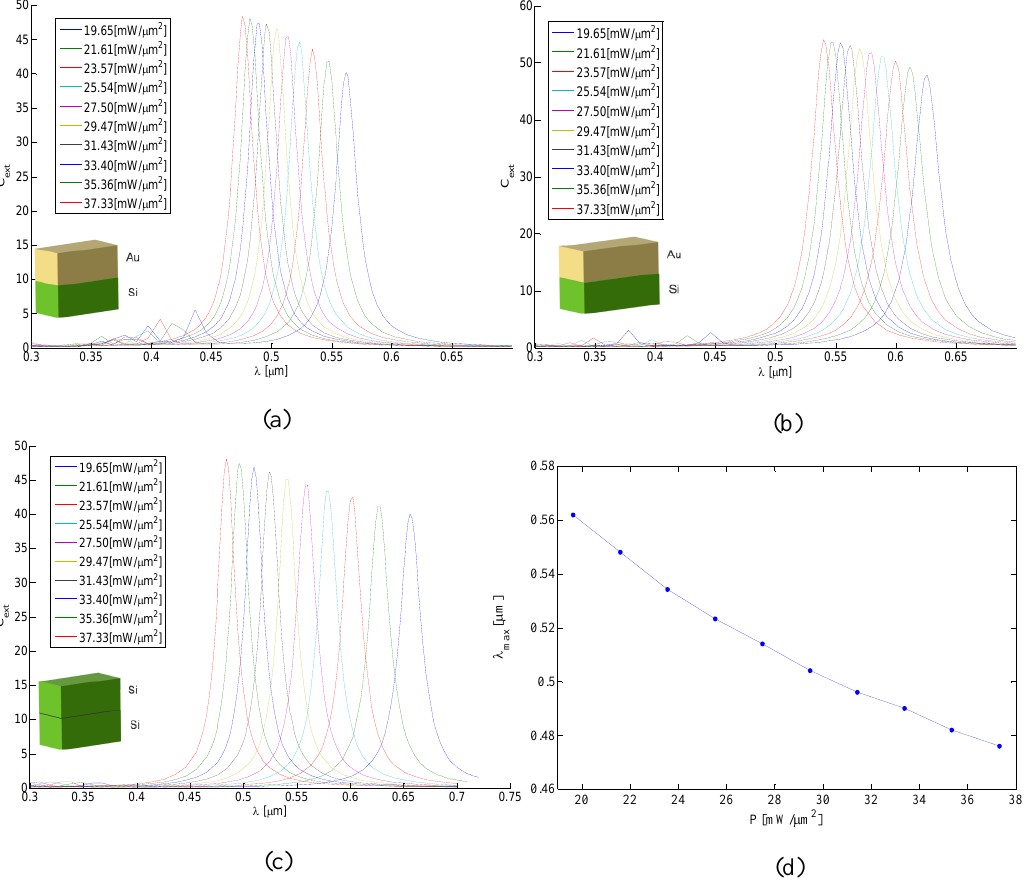
Figure 3. Simulation Results: (a) and (b) extinction cross section calculated for 40 nm long and 50 nm Au-Si structures, respectively; (c) Extinction cross section calculated for a Si nanoparticle; (d) Peak wavelength as a function of the pump intensity for a 40 nm long Au-Si